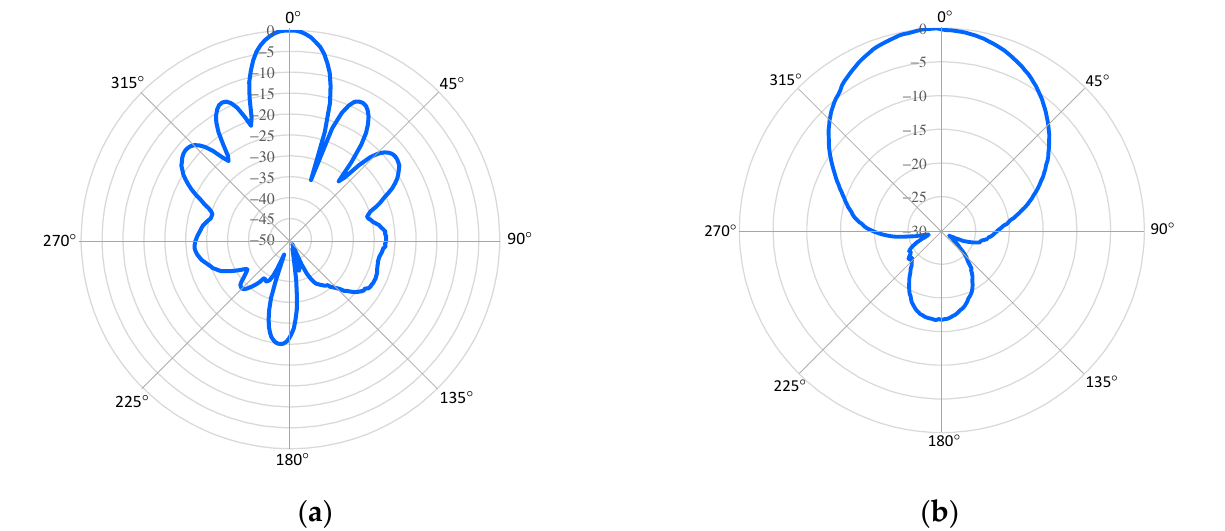
Figure 4. The radiation patterns: ( a ) 17.5 dBi gain antenna; ( b ) 9.5 dBi gain antenna. We attached the receiving antenna of 17.5 dBi to a stepper motor mounted on a pole to measure the signal distribution. The transmitter consisted of a radio-frequency generator connected to the antenna. We used the Lab Brick Signal Generator from Vaunix Technology Corporation [38], model LSG-602. This generator allows the transmission of a signal be- tween 1500 MHz and 6000 MHz, with an output power between − 45 dBm and 10 dBm. We used the spectrum analyzer FSH8 from Rohde and Schwarz [39] connected to the 17.5 dBi gain antenna as a receiver. The received power was recorded on a personal computer connected to the spectrum analyzer. The bandwidth considered in the measurements was 30 kHz. The system obtained about 300 samples in each complete rotation of the receiver